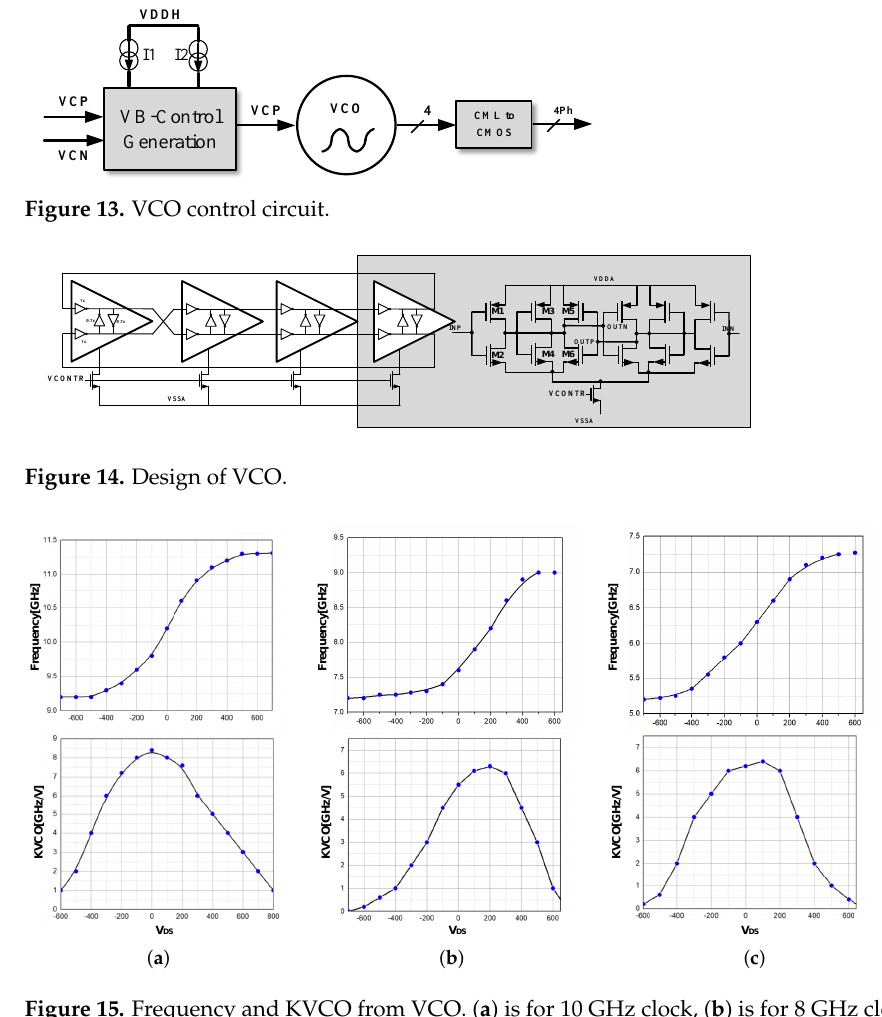
Figure 15. Frequency and KVCO from VCO. ( a ) is for 10 GHz clock, ( b ) is for 8 GHz clock, ( c ) is for 6 GHz